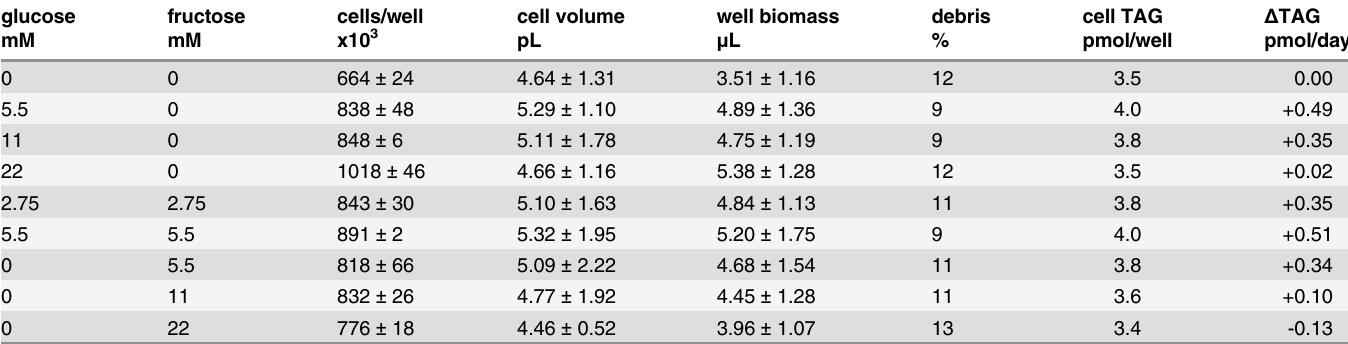
The data represent the mean ± SD of the analyses of three different (contiguous) wells with Transwell inserts. Well biomass represents the sum of volumes of all particles detected; the differences between cell volumes and total biomass is presented as well debris (as a percentage of total biomass). Cell triacylglycerols (TAG) were estimated, as described under Methods, assuming that at most 75% of the cell volume was made up of TAG. The estimations are an approximation made using only the mean values, as are the changes observed in biomass per cell (comparing the volumes of cells with those in the medium devoid of monosaccharides. The differences in cell volume (mass) were translated into estimated changes of triacylglycerol content per day. There were no statistically signi fi cant differences for cell volume, or type and concentration of monosaccharide (3-way